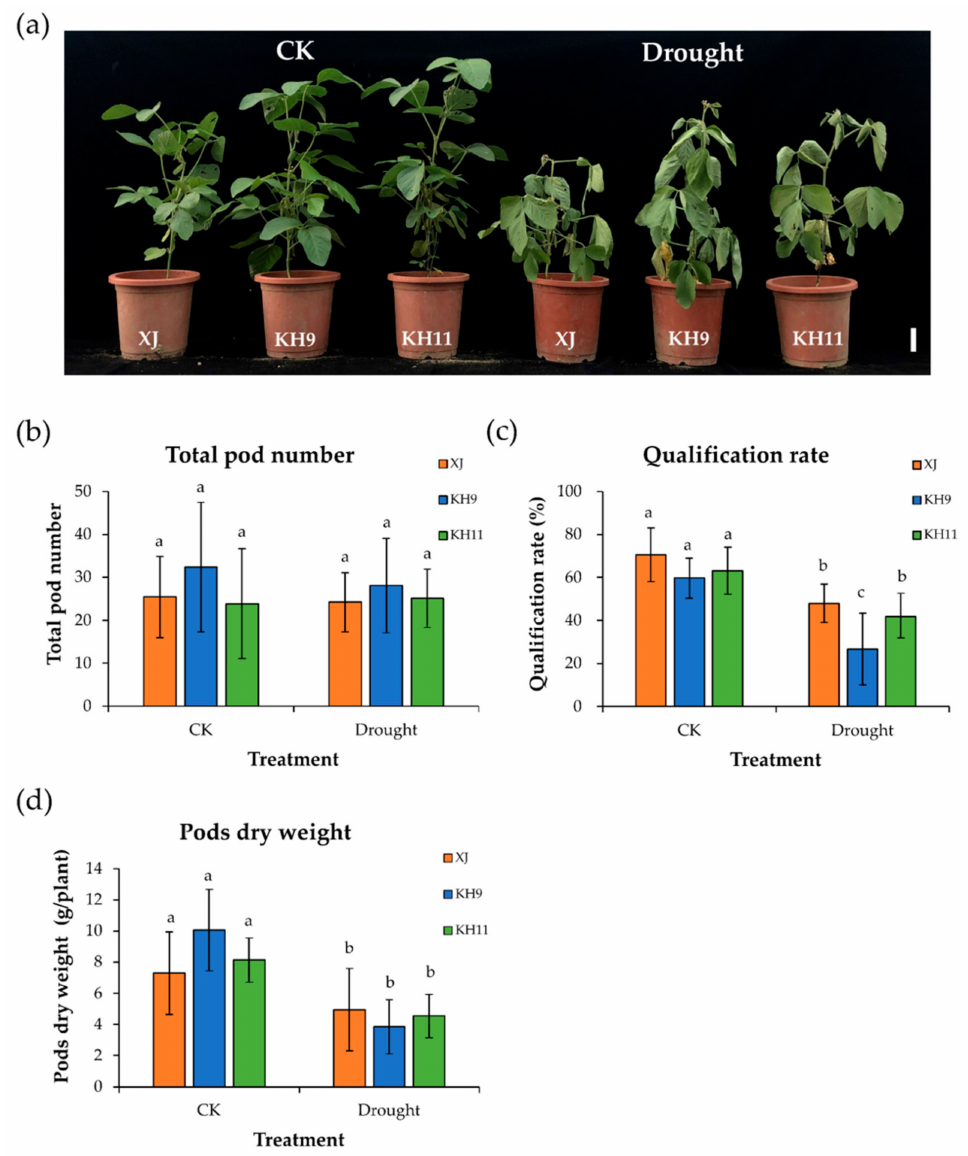
Figure 4. Drought affected the morphological appearances and the yields of XJ, KH9, and KH11. ( a ) Phenotypes of XJ, KH9, and KH11 under normal and drought conditions. ( b ) Total number of pods, ( c ) qualified rate, and ( d ) pods dry weight of XJ, KH9, and KH11 under normal and drought conditions. Bar = 5 cm. Values represent the mean ± SD of three biologically independent experiments. Different letters indicate significant differences between cultivars assessed using the LSD post hoc test ( p < 0.05). XJ, Xiang-Ji. KH9, Kaohsiung No. 9. KH11, Kaohsiung No. 11. CK, control